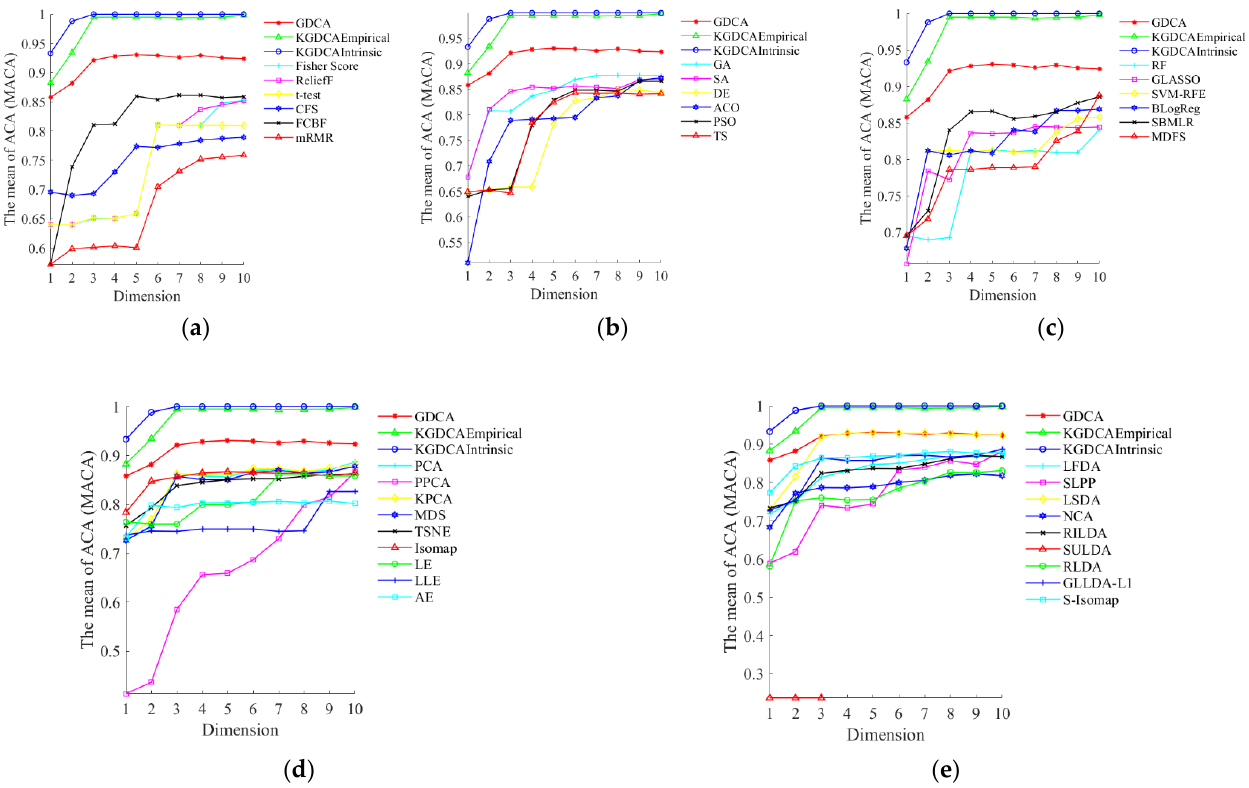
Figure 16. Comparisons with 36 kinds of state-of-the-art dimensionality reduction algorithms for MACA. ( a ) Feature selection algorithms of filter type. ( b ) Feature selection algorithms of wrapper type. ( c ) Feature selection algorithms of embedded type. ( d ) Unsupervised subspace projection algorithms. ( e ) Supervised subspace projection algorithms.